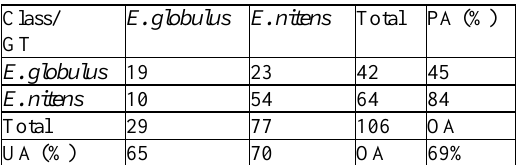
Table 3. Confusion matrix of the supervised classification performed to distinguish between E. nitens and E. globulus . The variable importance results for the random forest prediction